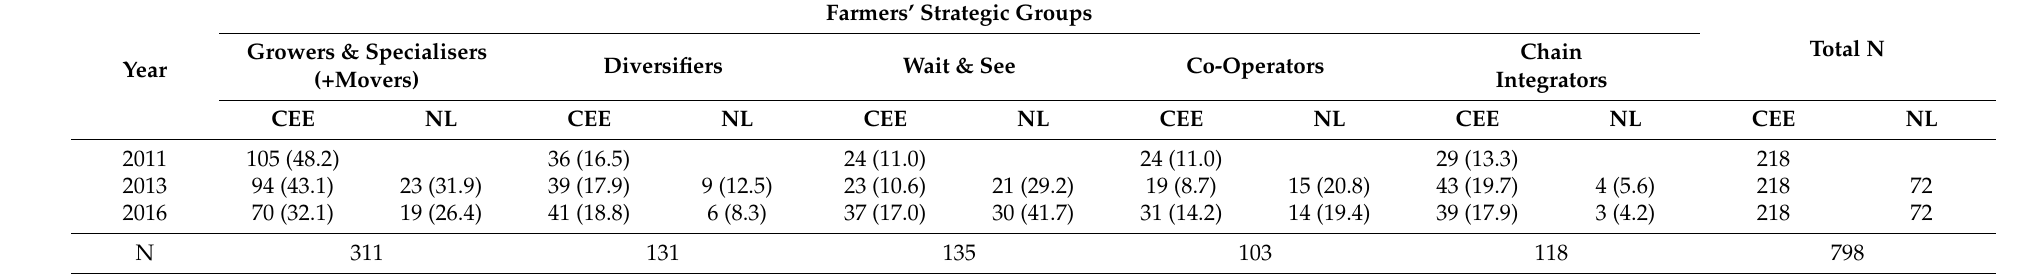
Table 3. Strategic groups of farmers in CEE countries and the Netherlands over the period 2011 to 2016—number and % of farmers (in